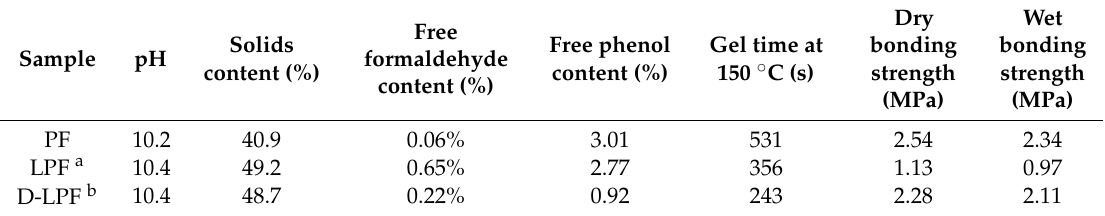
Table 9. Properties of PF, D-LPF, and LPF